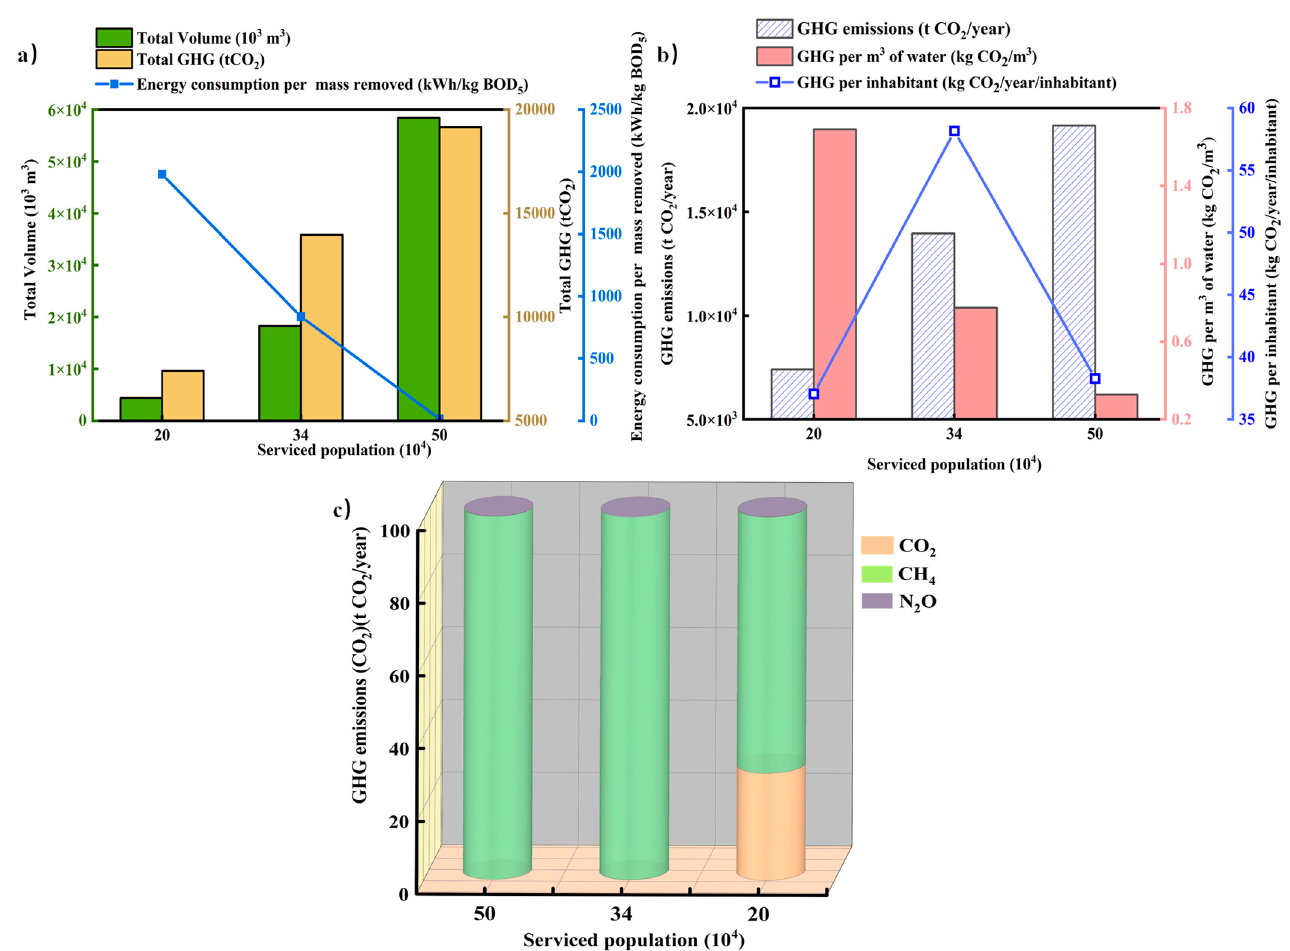
Figure 2. Relationship between population and water, energy consumption and GHG emissions in municipal wastewater treatment processes ( a ), the relationship between population and per capita GHG in municipal wastewater treatment process ( b ), and proportion of GHG emitted from municipal wastewater treatment processes ( c ).